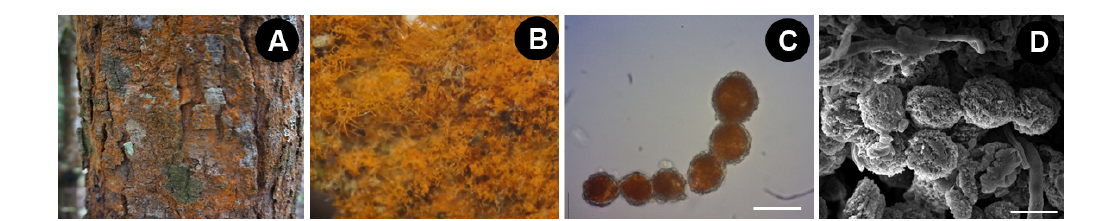
Figure 6 Subaerial green algae genus Trentepohlia at 13 sampling points in the rainy, winter, and summer seasons, including T. umbrina ( A–D ). Scale bars: 20 µ